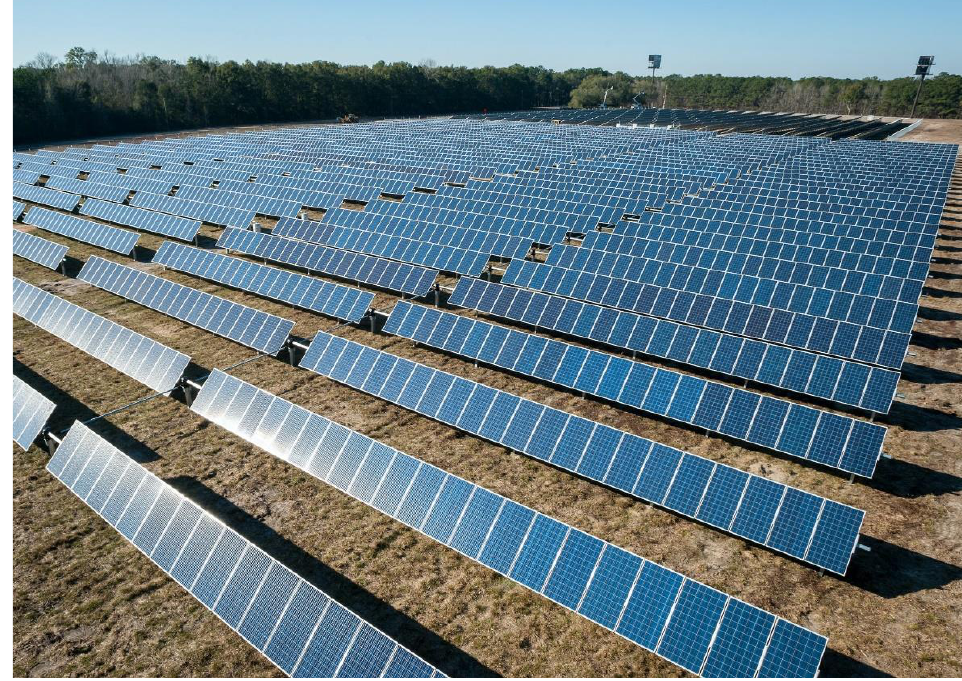
Figure 1. A typical solar farm obstructing the environment for flora and fauna over a large area. This cannot be good for nature [Photo: American Public Power